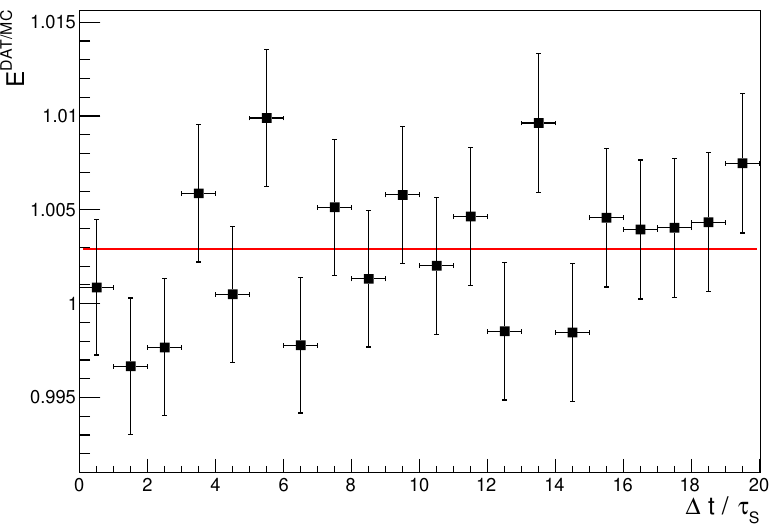
Figure 3 . Data/MC efficiency correction as a function of ∆ t . The superimposed line is the result of a fit with a